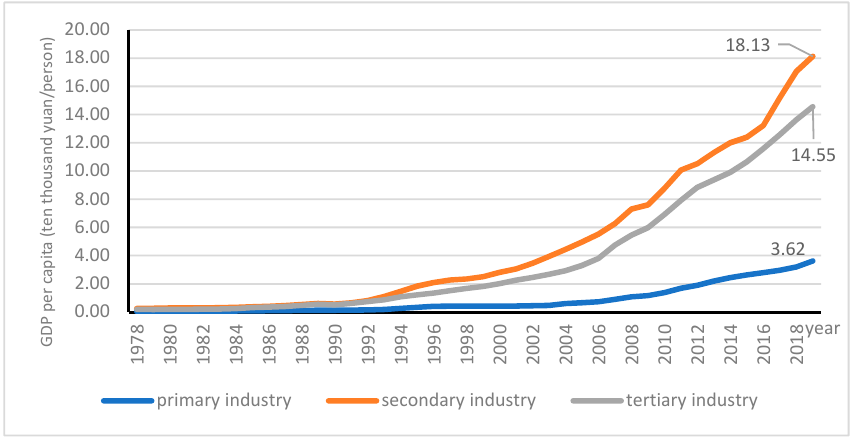
Figure 8. Annual per capita GDP output of three industries.